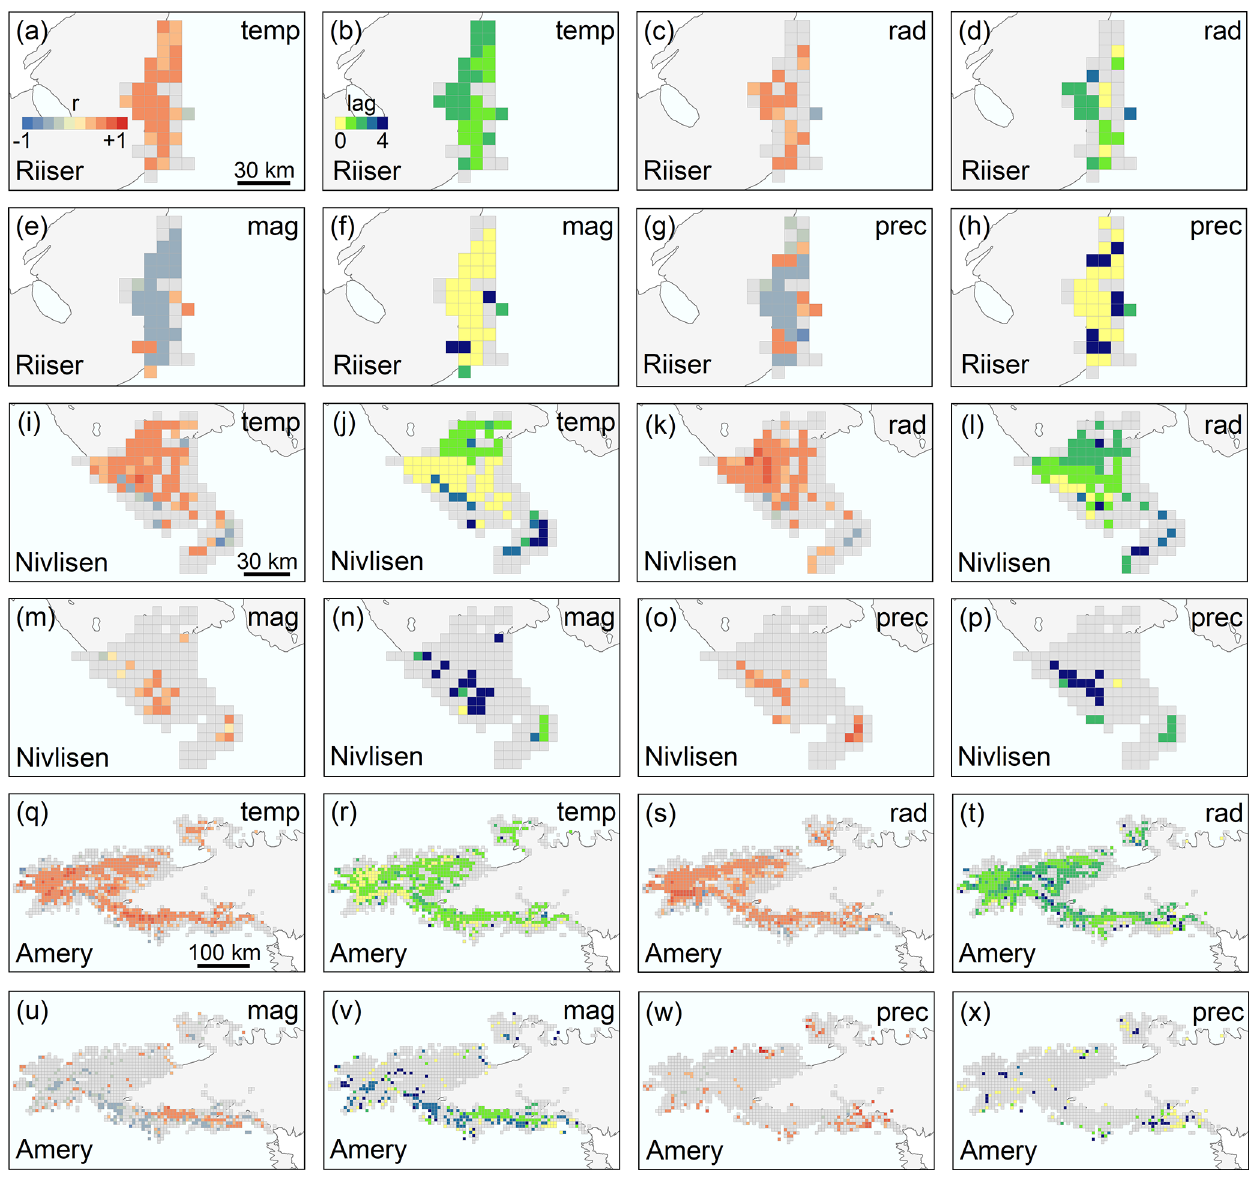
Figure 8. Pixel-based Pearson correlations ( r ) (a, c, e, g, i, k, m, o, q, s, u, w) and corresponding temporal lags (b, d, f, h, j, l, n, p, r, t, v, x) between fractional lake extents and climate variables air temperature (temp), solar radiation (rad), wind magnitude (mag) and precipita- tion (prec) over the EAIS ice shelves Riiser-Larsen (a–h) , Nivlisen (i–p) and Amery (q–x) . Pixels with p > 0 . 05 are masked. The coastline and grounding line (grey) data are from Mouginot et al. (2017) and Rignot et al.